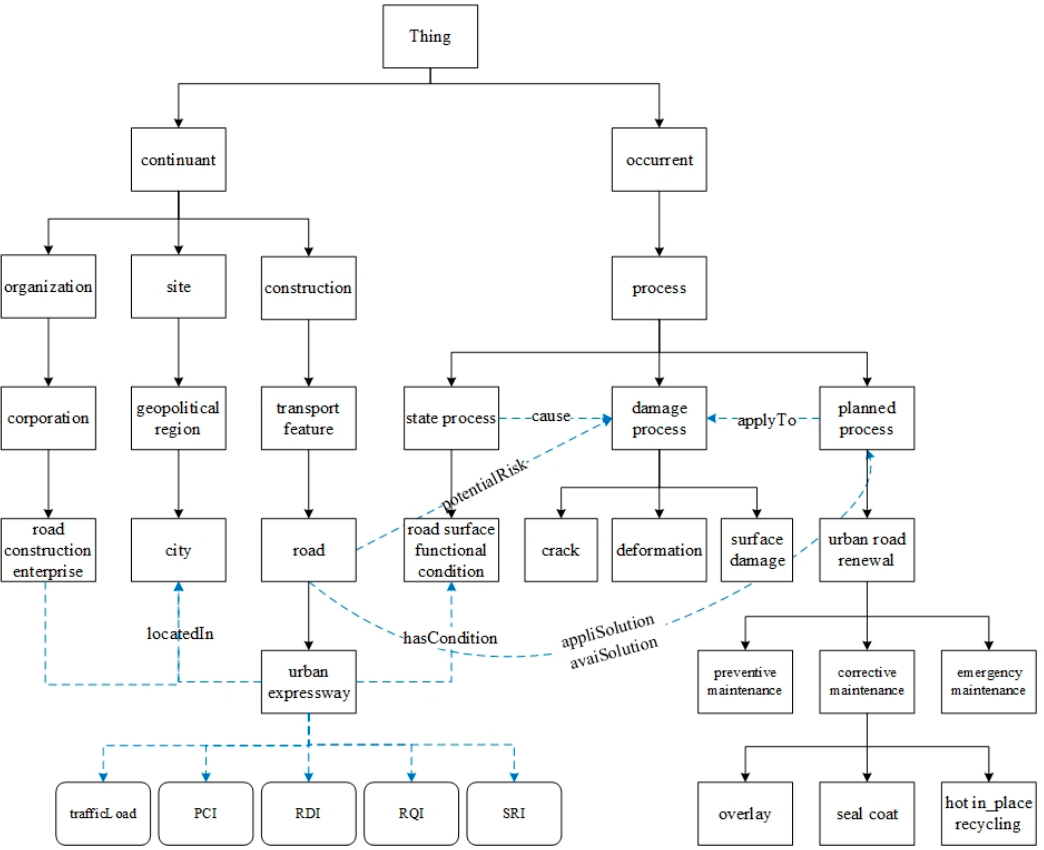
Figure 5. Conceptual model of urban expressway renewal.